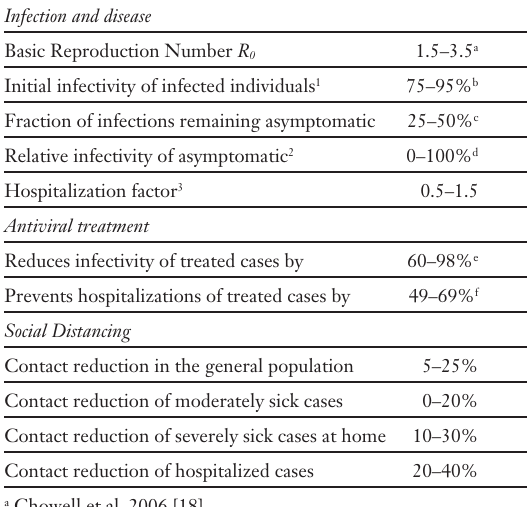
Stochastically sam- pled parameters and sampling